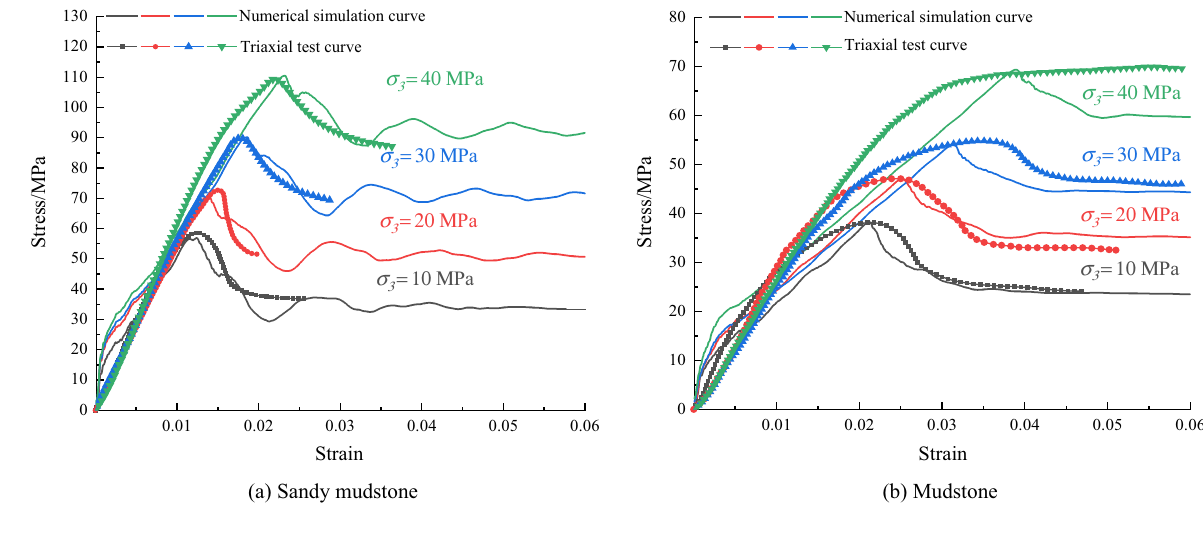
Fig. 13 Fitting graph of numerical simulation and experimental data